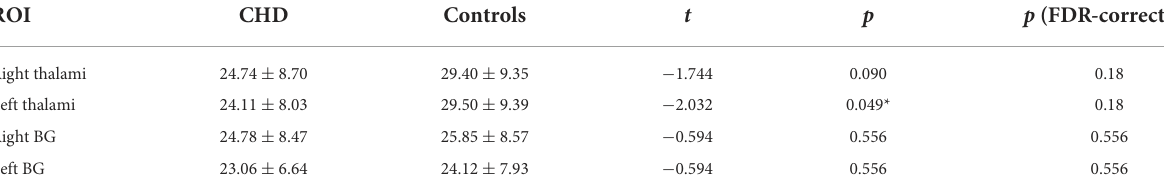
TABLE 3 Comparison of regional CBF by ASL between CHD and controls (mL/100 g/min). ROI CHD Controls t